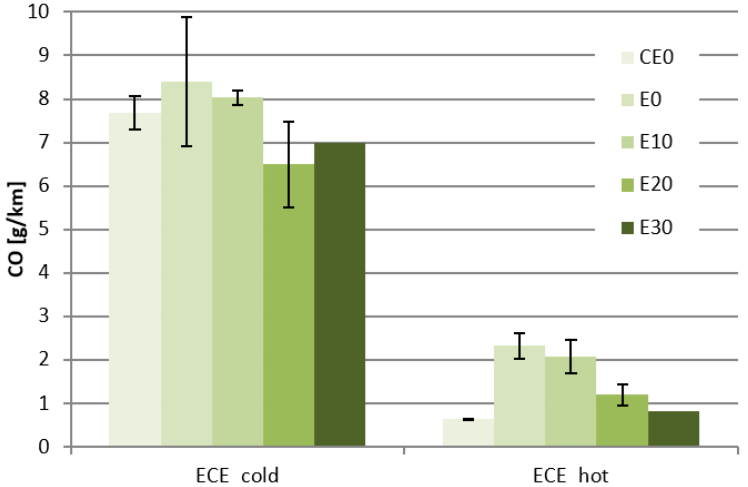
Figure 1. CO emission factors measured on the hot and cold phases of the ECE driving cycle: comparison between commercial gasoline (CE0), oxygen-free gasoline (E0), 10% ethanol v / v (E10), 20% ethanol v / v (E20) and 30% ethanol v / v (E30) [27]. Reproduced with permission from Applied